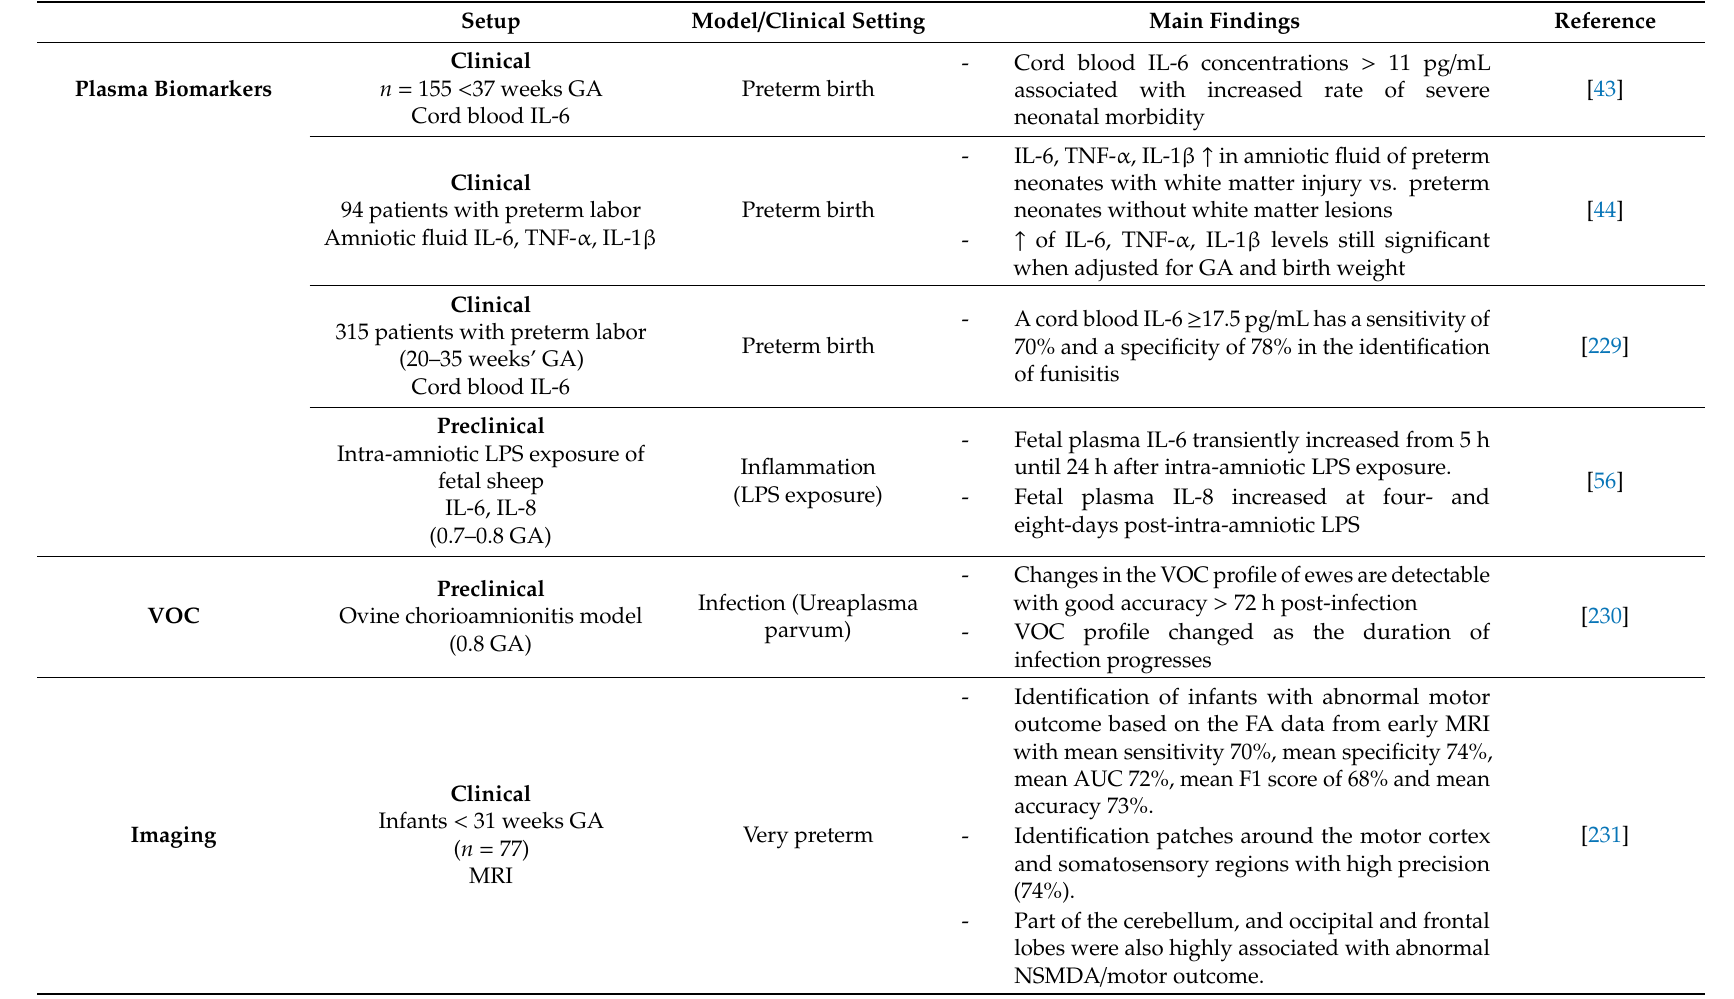
Table 2. Overview of the clinical and preclinical studies of diagnostic modalities (biomarker, imaging) for vulnerable neonates born preterm.